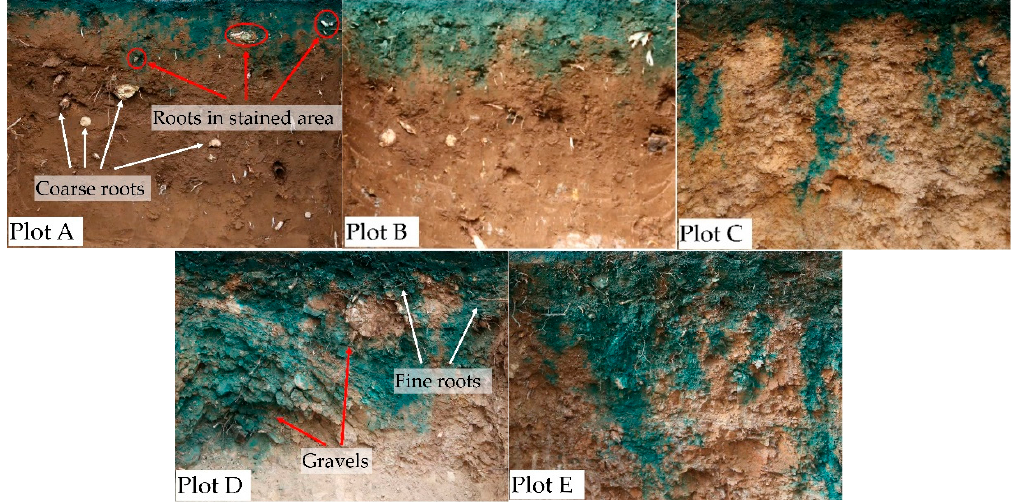
Table 2. Mean soil physical properties of the experimental plots on the hillslope (A: bottom; B: lower; C: middle; D: upper; E: top).